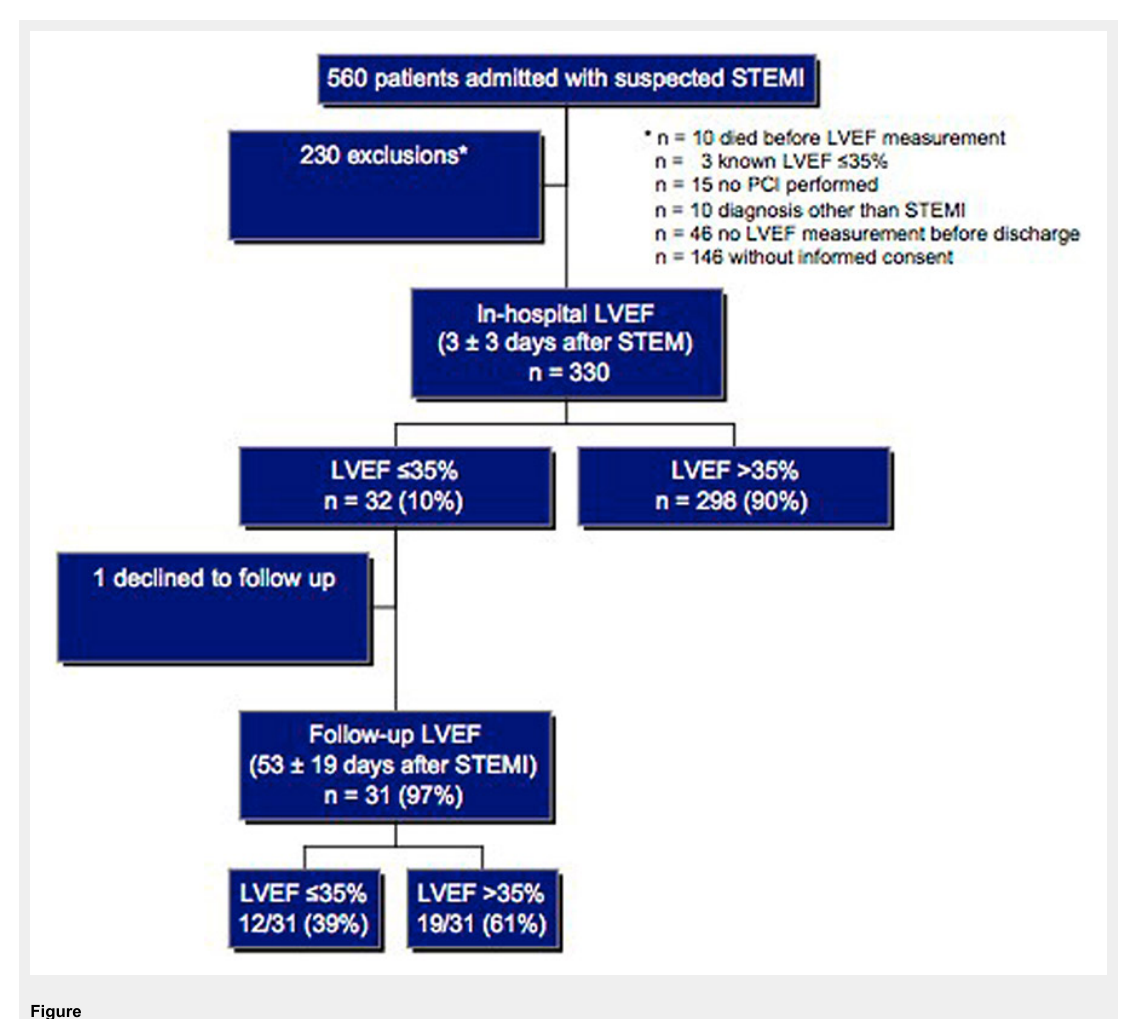
Figure Study flow chart – patient recruitment and group outcome. LVEF = left ventricular ejection fraction; STEMI = ST-segment elevation myocardial